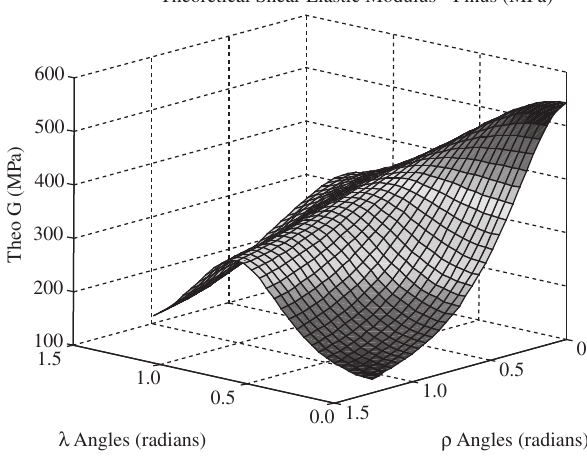
Figure 10. Three -Dimension diagram of Elastic Modulus and Euler’s angles for Pinus.